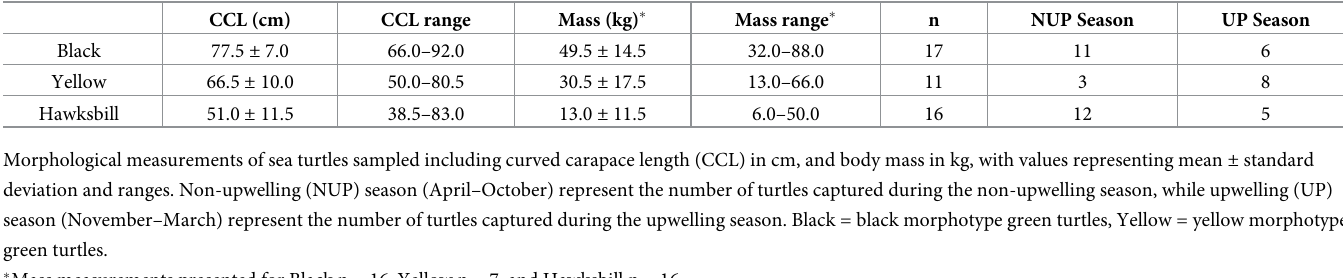
Table 1. Morphological measurements and capture data of sea turtles foraging in Pacific Costa Rica.